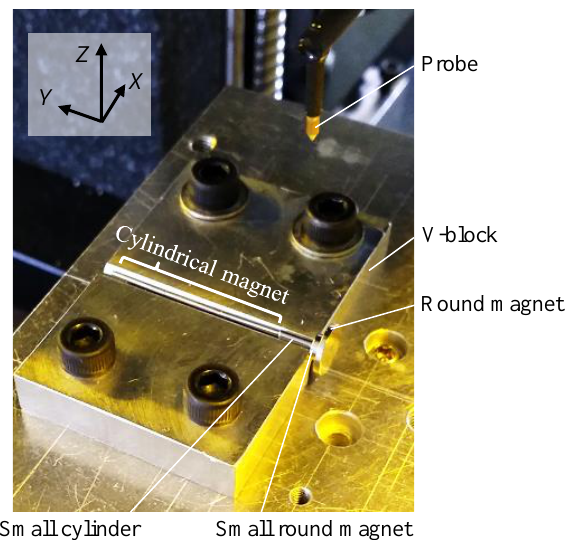
Figure 18. A photograph of the setup with a small magnet.